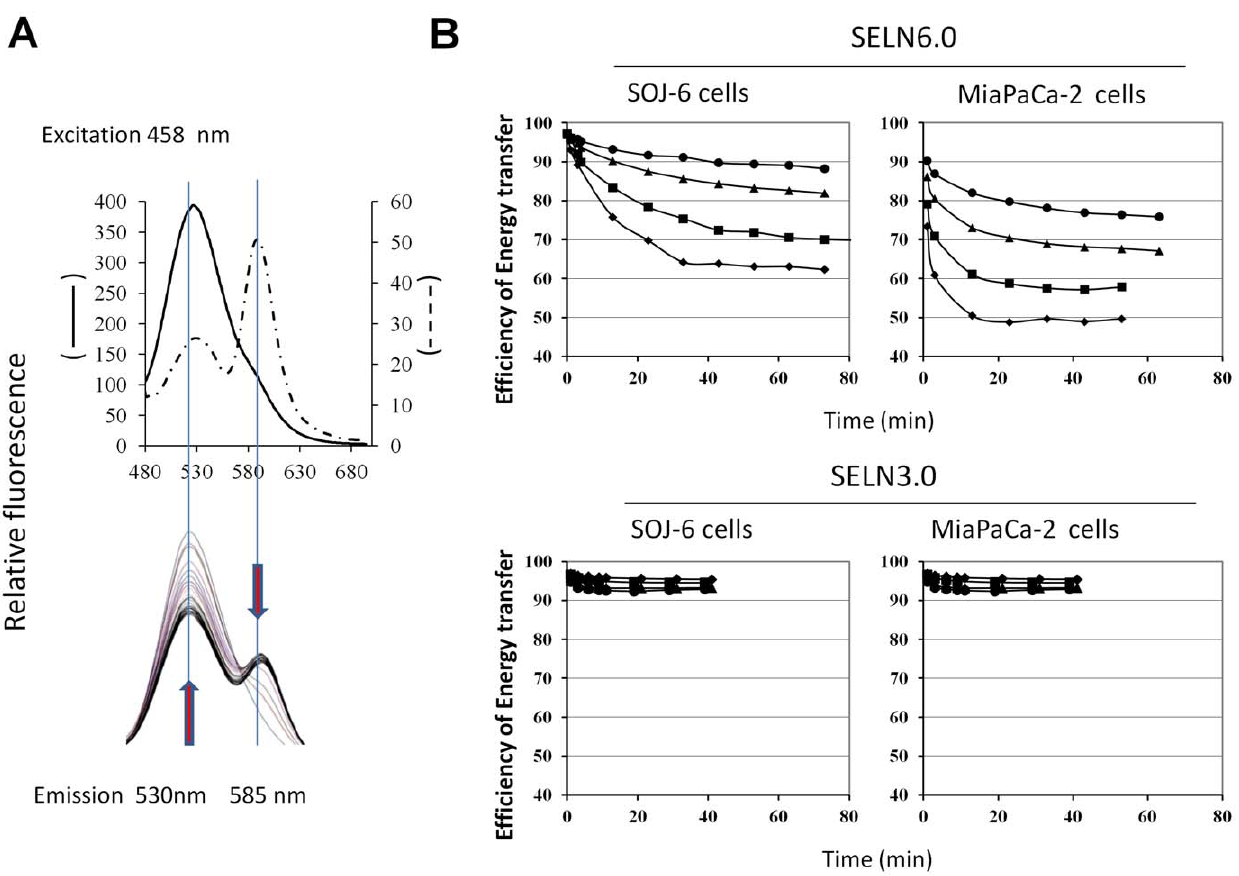
Figure 8. SELN interactions with SOJ-6 and with MiaPaCa-2 cells. (A) Left spectrum depicts a typical FRET obtained with SELN6.0 labeled with N -NBD-PE and N -Rh-PE. Once excited at 458 nm, N -NBD-PE transfers energy to N -Rh-PE generating light emission at 585 nm (dashed line curve, upper panel). When SELN6.0 preparation was diluted in a micellar solution of detergent (Tween 20, 1% final) the FRET depicted by the 585 nm emission peak disappears to favor N -NBD-PE maximal emission (f 0 ) at 530 nm (single line curve, in upper panel). The lower panel shows typical variation of fluorescence emission (following excitation at 435 nm) of SELN6.0 (50 m l) in the presence of 1.0 6 10 6 SOJ-6 cells. Arrows indicate variations in fluorescence emission with time (0 min up to 60 min, 3 min steps). (B) Variation with time of the energy transfer efficacy E =1-(f/f 0 ) when cells were mixed with SELN. f 0 is determined at the end of each experiment (see A). Typical data obtained with : and ¤ 2.0 6 10 6